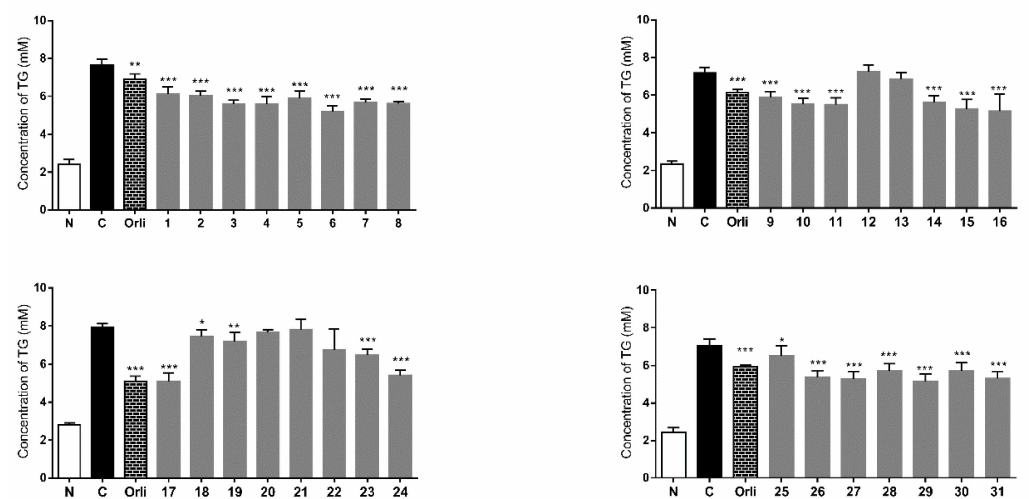
Figure 9. TG accumulation inhibitory effects of 1 – 31 in HepG2 cells. TG relative concentration: percentage of control group, which set as 100%. Values represent the mean ˘ SD of determinations ( n = 8). * p < 0.05; ** p < 0.01; *** p < 0.001 vs. control group. Final administrated concentration of 1 – 31 was 10 µ M, and oristat was 0.5 µ M.